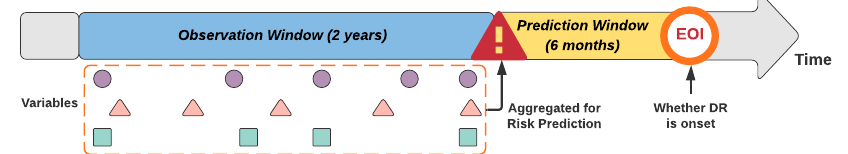
Figure 1. Prediction and observation windows for the predictive